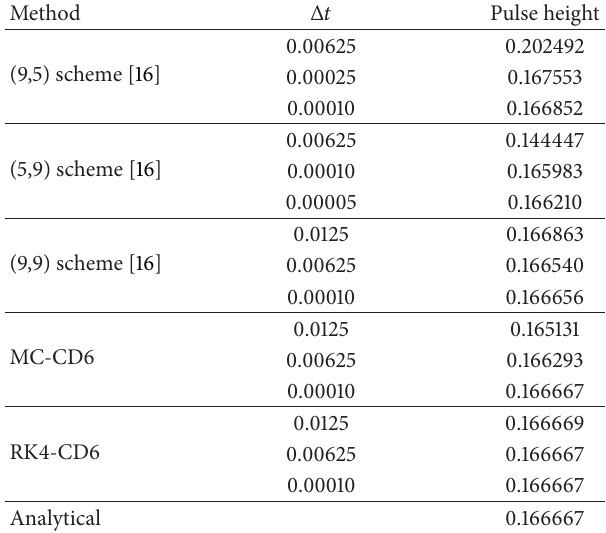
Table 2: Comparison of average absolute and maximum absolute errors with the literature.